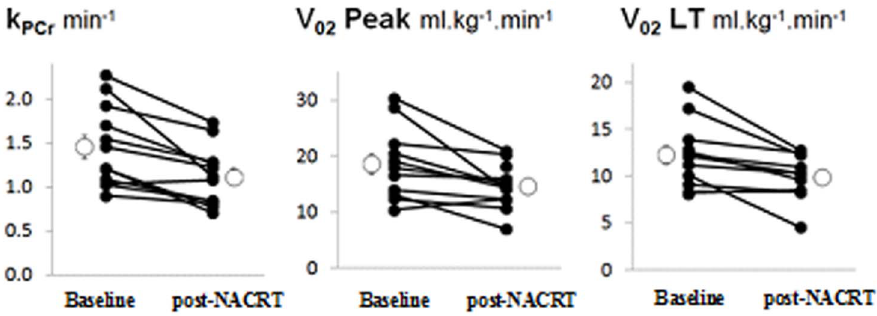
Figure 2. 31 P MRS (k PCr ) and CPET ( _ V o 2 at ^ h L and _ V o 2 at Peak) data at Baseline (before NACRT)) and at 48 ¡ 5 hours post-NACRT: lines link data-points (closed circles) for individual patients, and open circles show overall mean ¡ SEM. Mean changes (SEM) between baseline and post-NACRTare for k PCr 2 0.4(0.1) min 2 1 , p 5 0.001; for _ V o 2 at ^ h L 2 2.4(0.7) ml.kg 2 1 .min 2 1 , p 5 0.004; and for _ V o 2 Peak 2 4.0(1.3) ml.kg 2 1 .min 2 1 , p 5 0.011.